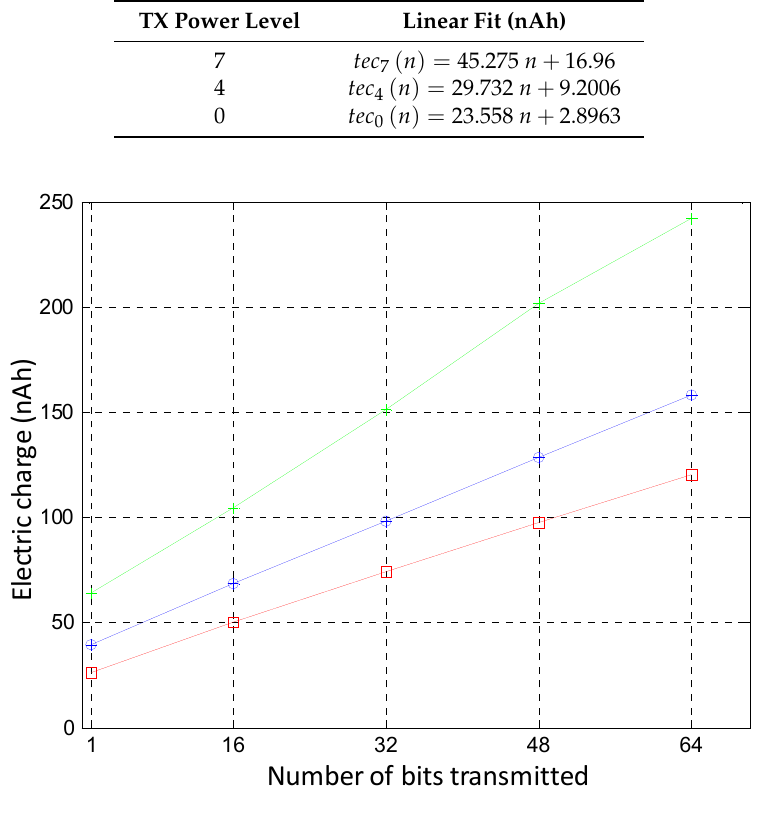
Figure 8. Electric charge for different transmission power and payloads.